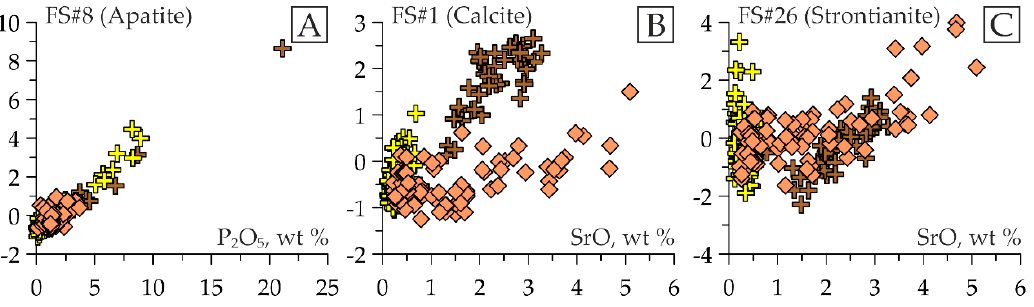
Figure 9. Figurative points of the samples on the diagrams in the coordinates ( A ) FS s of apatite factor–P 2 O 5 content (wt%); ( B ) FS s of calcite factor–SrO content (wt%); ( C ) FS s of strontianite factor–SrO content (wt%). Legend: peach rhombs—undifferentiated rocks of carbonatite sequence (drill core #6); brown crosses—carbonatites sensu stricto (mostly calcium) from explosion pipe (drill core #7); yellow crosses—silicocarbonatites and carbonate-bearing silicate rocks from the explosion pipe (drill core #7).